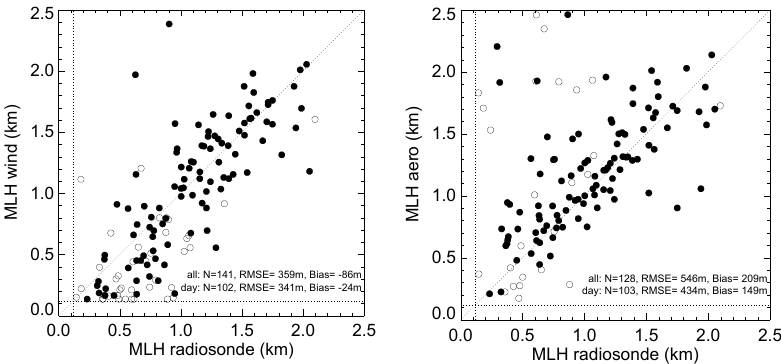
Figure 3. MLH wind (left) and MLH aero (right) versus MLH sonde derived from HOPE data during April and Mach 2013. Filled symbols mark daytime (08:00–16:00UTC) and open symbols night-time